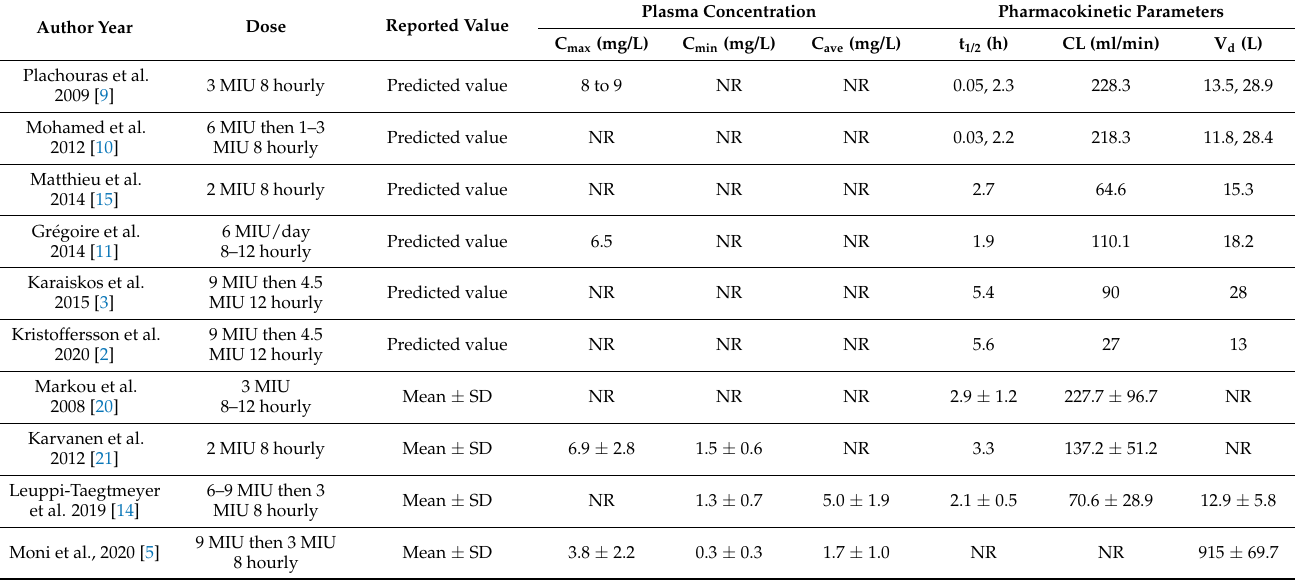
Table 3. Comparison CMS pharmacokinetics parameters in plasma at steady